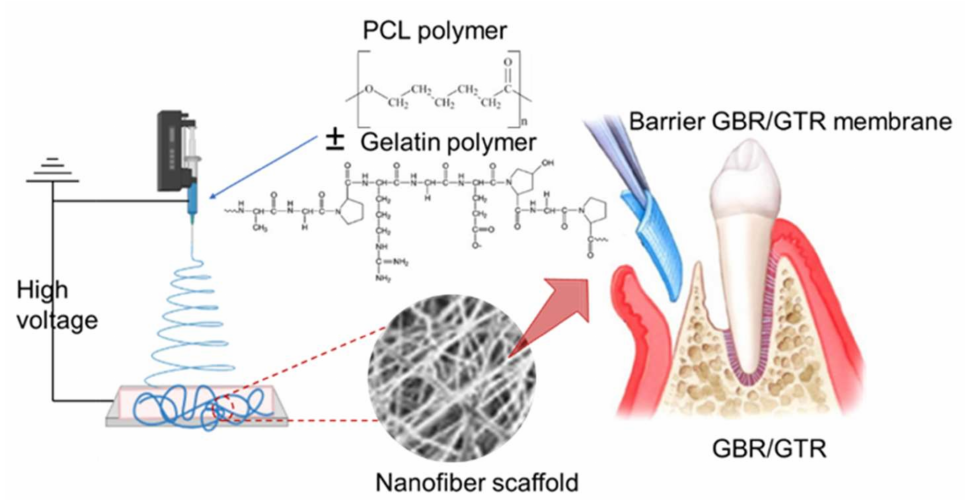
Figure 4. Development of a barrier membrane using the ES technique for the localized delivery of antibacterial agent in GBR/GTR